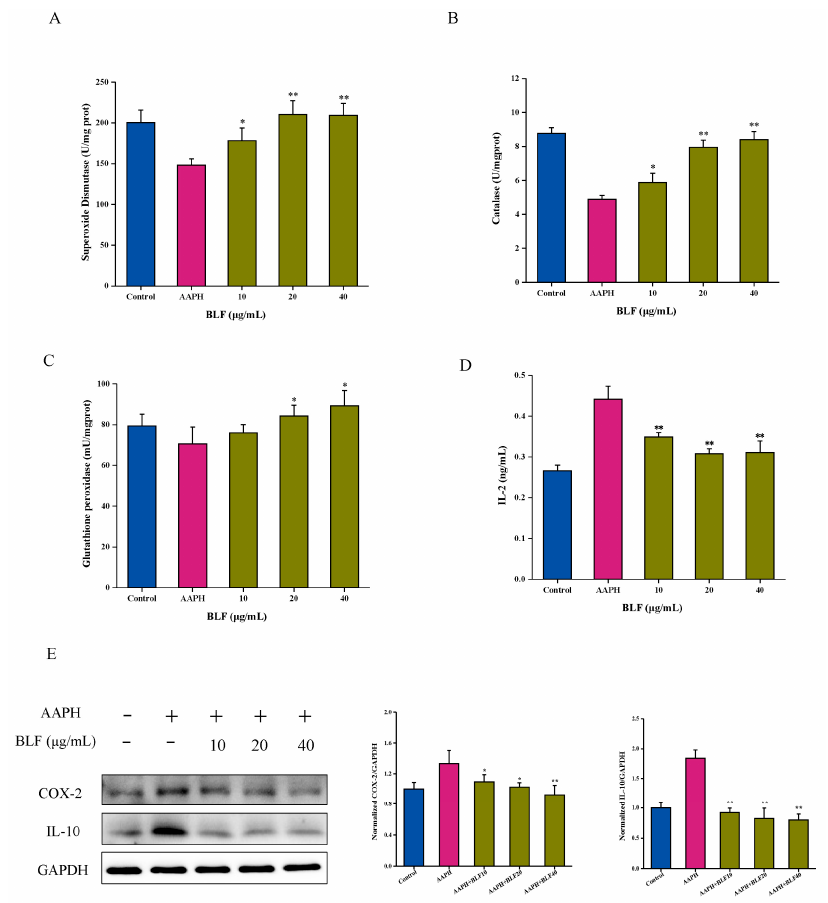
Figure 3. BLF increased the activity of antioxidant enzymes and inhibited the expression of inflammatory factors. ( A ) Superoxide dismutase determined by total SOD assay kit with WST-8 and detected by microplate reader. ( B ) Catalase determined by catalase assay kit. ( C ) Glutathione peroxidase determined by cellular glutathione peroxidase assay kit with NADPH. ( D ) IL-2 detected using human IL-2 ELISA kit. ( E ) Protein expression of COX-2 and IL-10 determined by Western blotting (left). Quantitation is shown on the right. * p < 0.05, ** p < 0.01 vs. AAPH treated group.